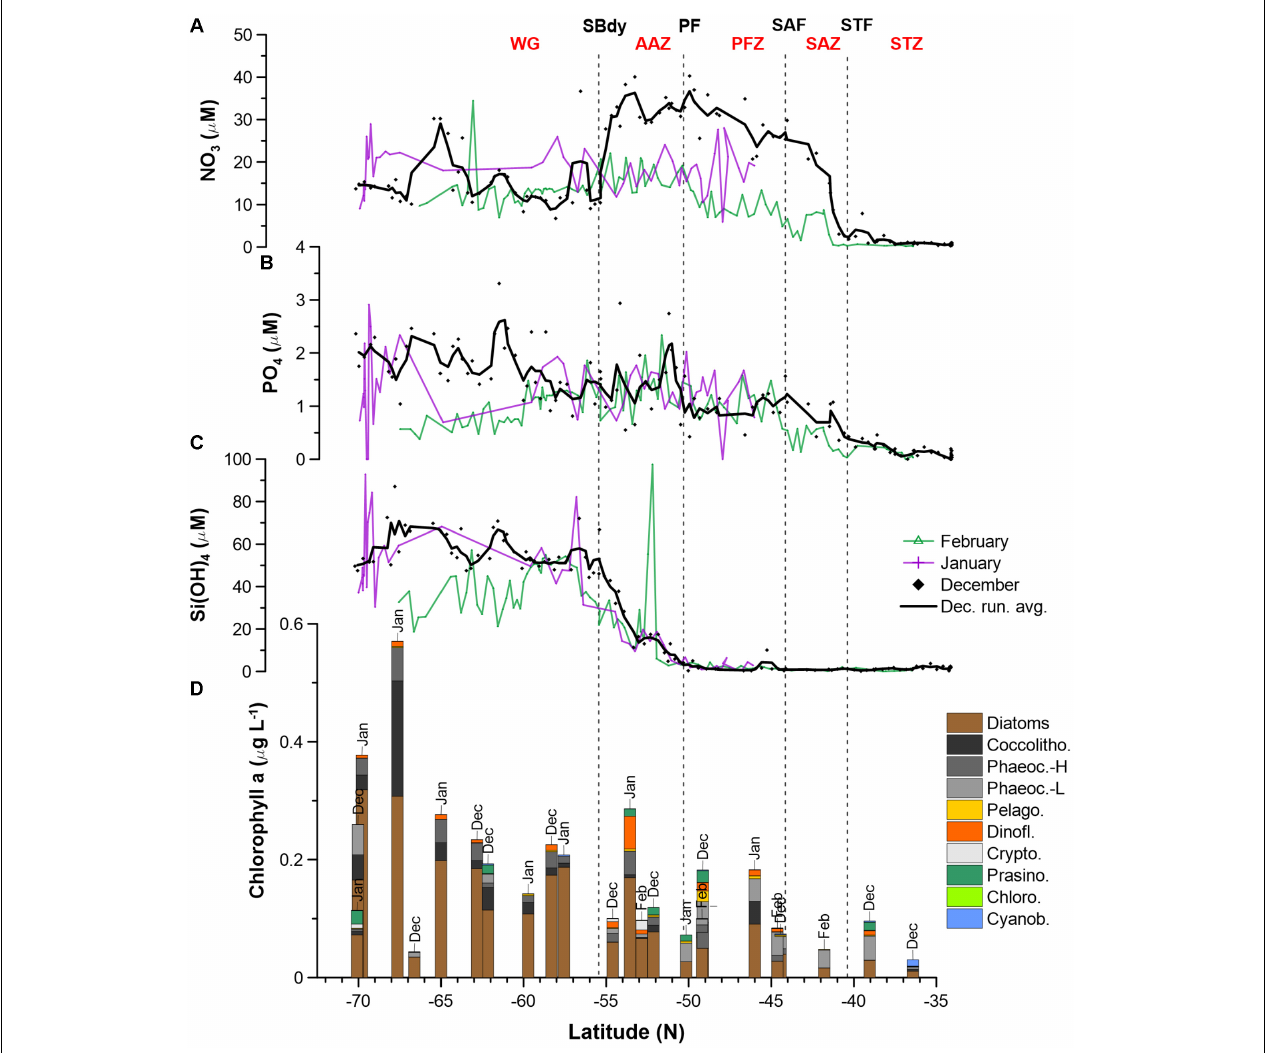
FIGURE 2 | Macronutrient ( A: NO 3 ; B: PO 4 ; C: H 4 SiO 4 ) concentrations and phytoplankton community structure (D) along the Good Hope monitoring Line during the SANAE54 cruise (see Figure 1 for cruise map). Averages and ranges of macronutrient concentrations and ratios, per water mass, can be found in Supplementary Figure S2 and Supplementary Table S2 . Detailed phytoplankton pigment concentrations and group contributions to chla can be found in Supplementary Tables S5, S7 and Supplementary Figure S3 .